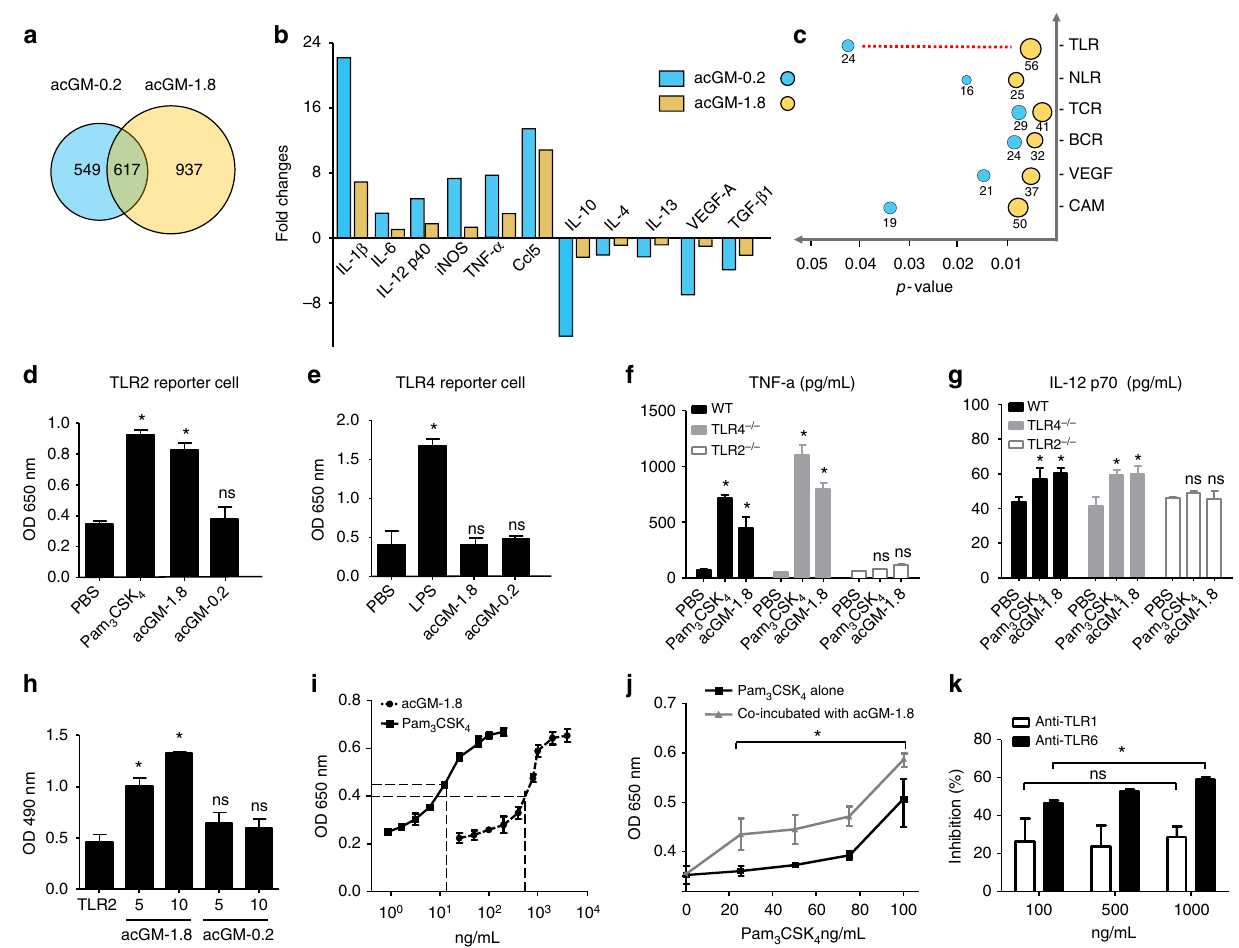
Fig. 4 acGM1.8 speci fi cally activates TLR2 signaling. a – c Microarray data on the gene expression in BMDM treated with acGM-1.8 or acGM-0.2: a Venn diagram of the gene numbers, ( b ) fold change of the markers related to macrophage polarization, and ( c ) top six signaling pathways changed after the treatment, where the numbers under the circles represent counts of different genes and the toll-like receptor (TLR) signaling pathway shows the greatest change. d , e Detection of secreted embryonic alkaline phosphatase (SEAP) activity in ( d ) TLR2 and ( e ) TLR4 reporter macrophages after the treatment of PBS, acGM-1.8, acGM-0.2, or the corresponding agonist. f , g Determination of cytokines ( f ) TNF- α and ( g ) IL-12 p70 secreted by macrophages of TLR- knockout mice or wild type mice (* P < 0.05 vs. the PBS group; n = 3). h Detection of acGM-1.8 or acGM-0.2 bound to TLR2: the TLR2 protein was pulled down and the bound polysaccharides were detected by sulfuric-phenol assay (* P < 0.05 versus the group of pure TLR2 without polysaccharides; n = 3). i Measurement of the EC 50 value of acGM-1.8: the TLR2 HEK-Blue cells were incubated with acGM-1.8 or Pam 3 CSK 4 for 24 h, and the level of SEAP was recorded. j Assessment of potential competition between acGM-1.8 and the classical TLR2 agonist Pam 3 CSK 4 : the TLR2 HEK-Blue cells were treated with Pam 3 CSK 4 alone (1 to 100 ng/mL) or Pam 3 CSK 4 (1 to 100 ng/mL) along with acGM-1.8 ( fi xed at 1 µ g/mL), and the level of SEAP was recorded. * P < 0.05 between the two compared groups; k Assessment of the role of TLR1 or TLR6 in acGM-1.8 ’ s activation of TLR2: the TLR2 HEK-Blue cells were pre- incubated with anti-TLR1 or anti-TLR6 before the addition of acGM-1.8 (100 µ g/mL). The culture medium was collected and the level of SEAP was recorded. For ( k ), * P < 0.05 between two inhibition at 100 ng/mL and 1000 ng/mL, n = 3. Data are representative for three independent experiments, except for the microarray data representing two independent biological samples. The original data for ( a – c ) are submitted to GEO; ns: no signi fi